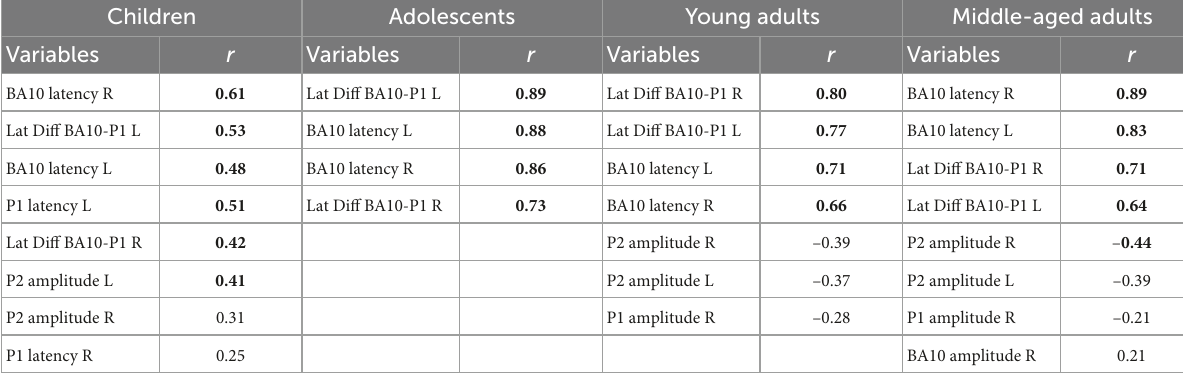
fivefold shorter BA10-P1 latency differences right side: children: latency difference in musicians 12.3 ms, in non-musicians 28.8 ms ( p = 0.05, r = 0.33), adolescents: 19.1 vs. 44.8 ms ( p < 0.001,